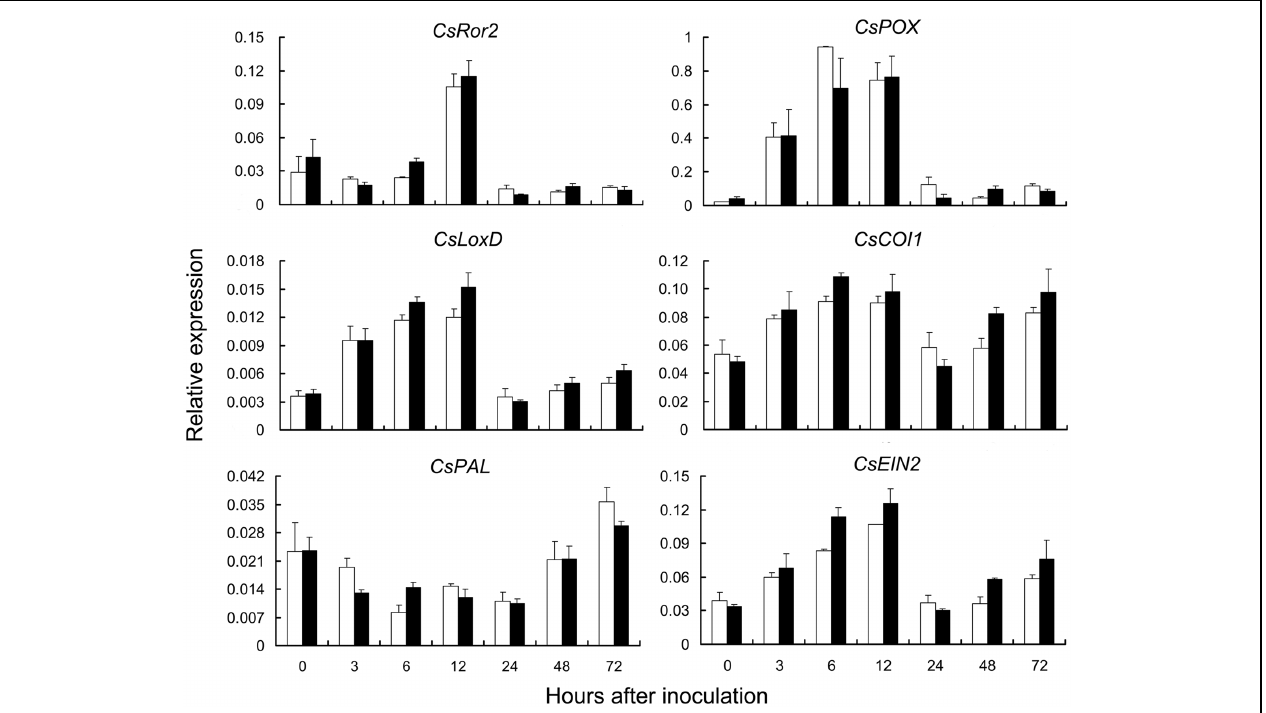
FIGURE 6 | Expression patterns of plant defense-response related genes in resistant S1003 and susceptible NIL( Pm5.1 ) plants after PM inoculation. CsRor2 is an ortholog of barley Ror2 , which is required for PM resistance. CsPOX is a peroxidase gene. CsLoxD and CsCOI1 are JA synthesis-related genes. CsPAL is an SA synthesis-related gene. CsEIN2 is an ethylene signaling pathway receptor gene. The cucumber CsActin gene was used as a reference control. Open bars, resistant S1003; solid bars, susceptible NIL( Pm5.1 ). Values are mean ± SE ( n = 3). No genes showed a significant difference between S1003 and NIL( Pm5.1 ) at any time point after